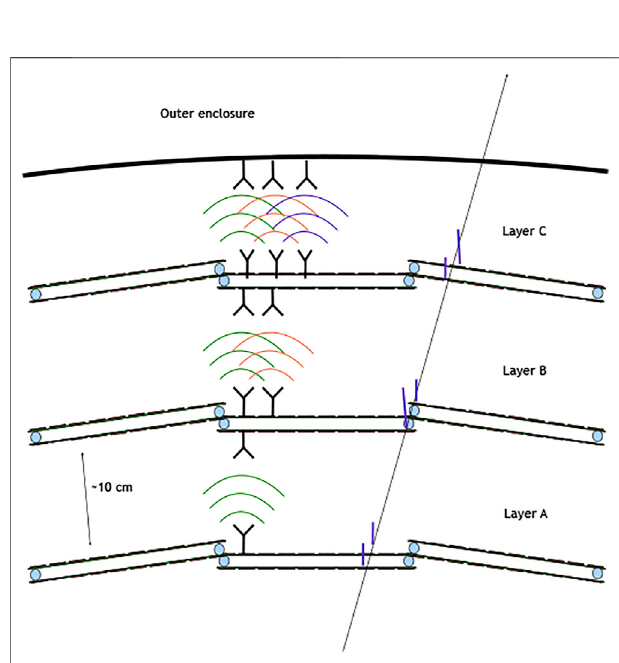
FIGURE 3 | Proposal of a radial readout for the tracking detector of the ATLAS